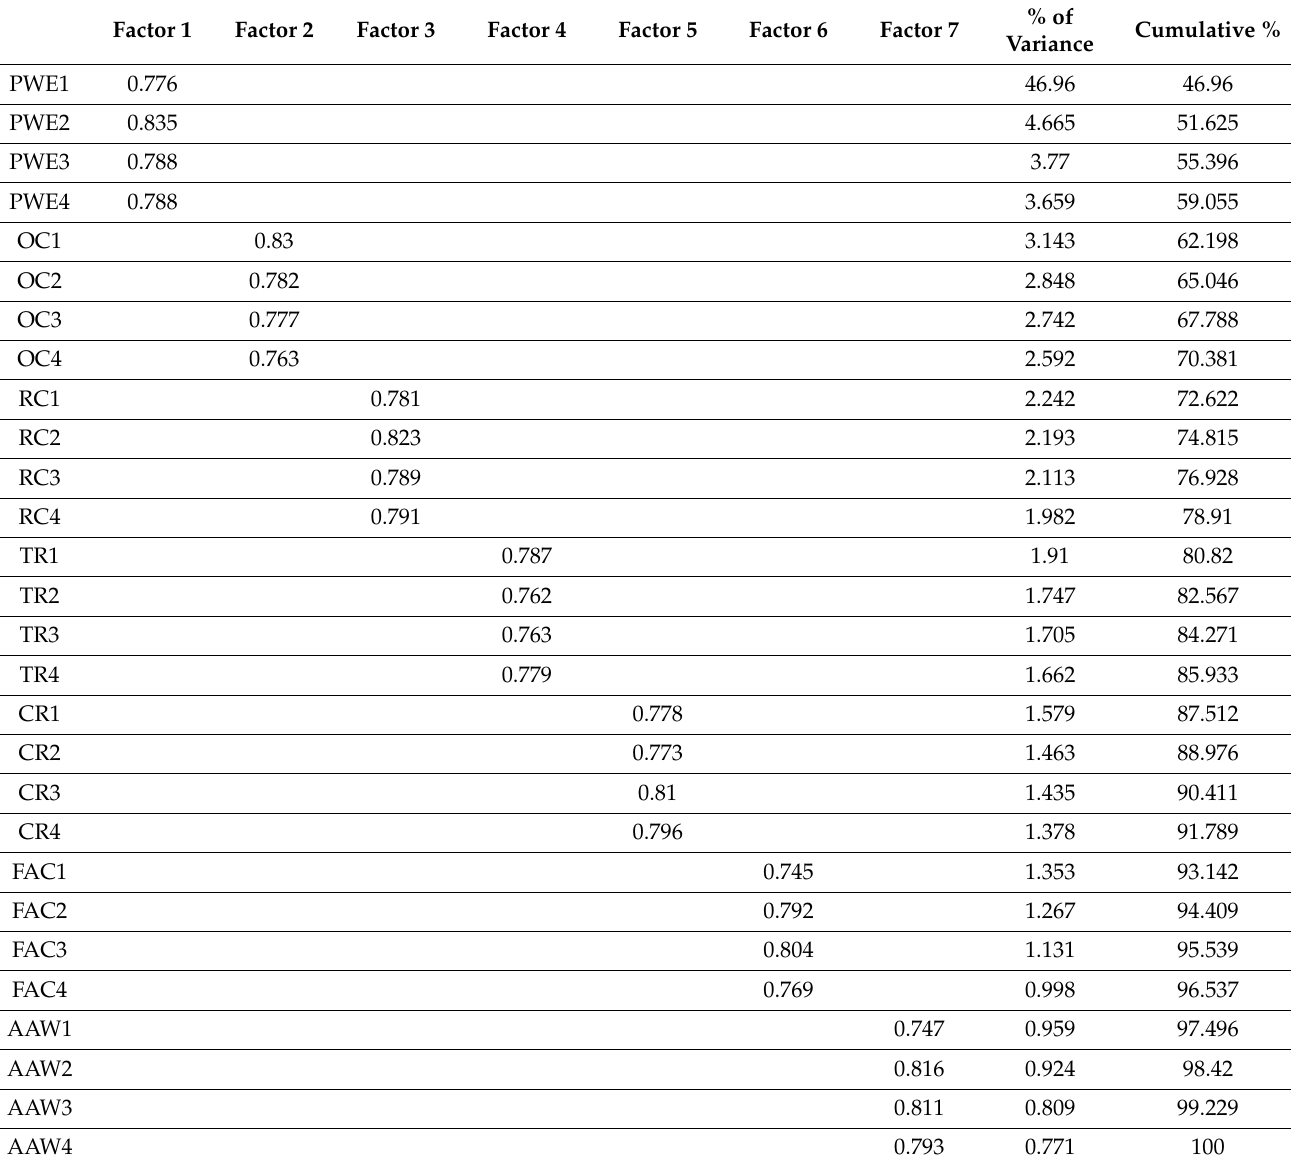
Table 4. Factors extracted (principal